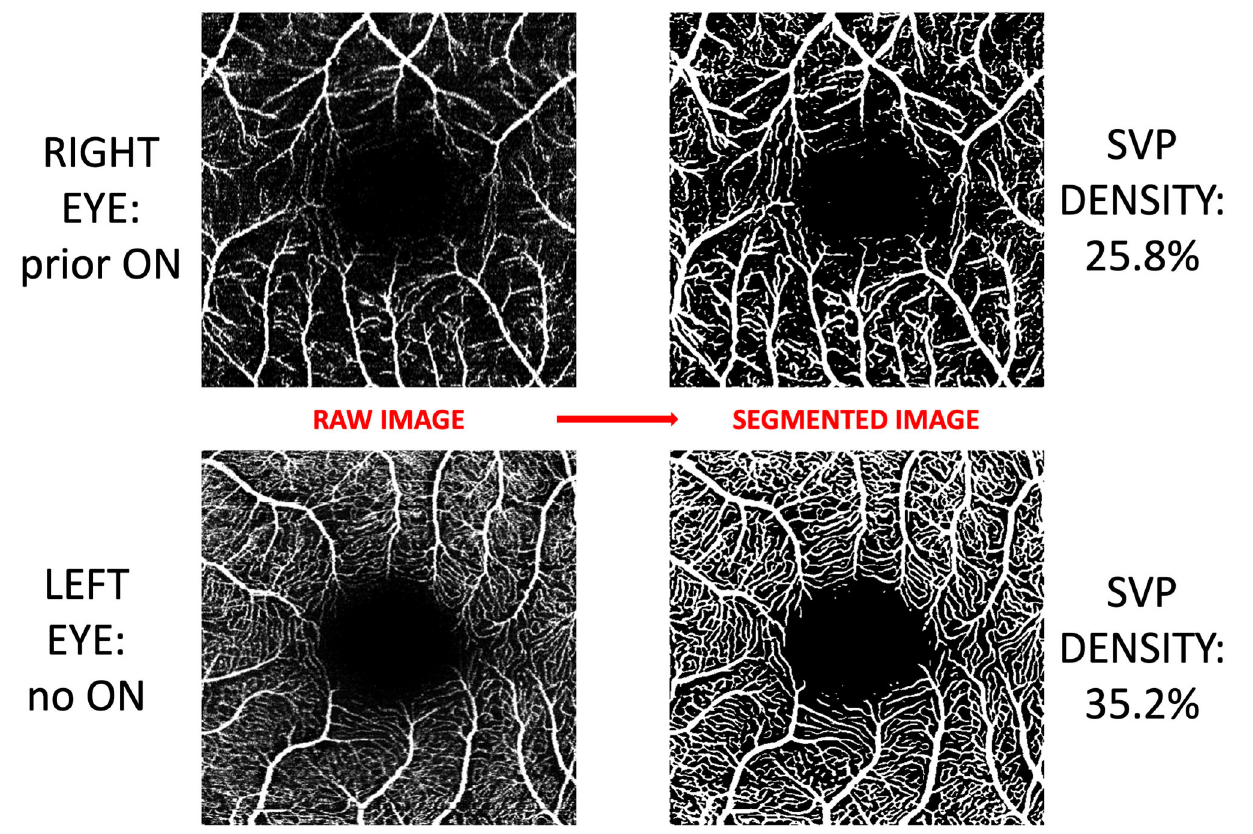
FIGURE 1 | Post-acquisition processing and segmentation of OCTA images. Images of the superficial vascular plexus (SVP) were acquired using Spectralis OCTA (Heidelberg Engineering, Germany). A neural network algorithm developed at Johns Hopkins University was trained to exploit the shared vessel structures from repeated scans acquired by two different OCTA devices while suppressing the scan-dependent noises and artifacts. The trained algorithm generates a vessel mask for each scan for computing SVP density. In this figure, OCTA images from both eyes of a patient with a history of optic neuritis are demonstrated. Inter-eye difference in SVP density in this patient was −